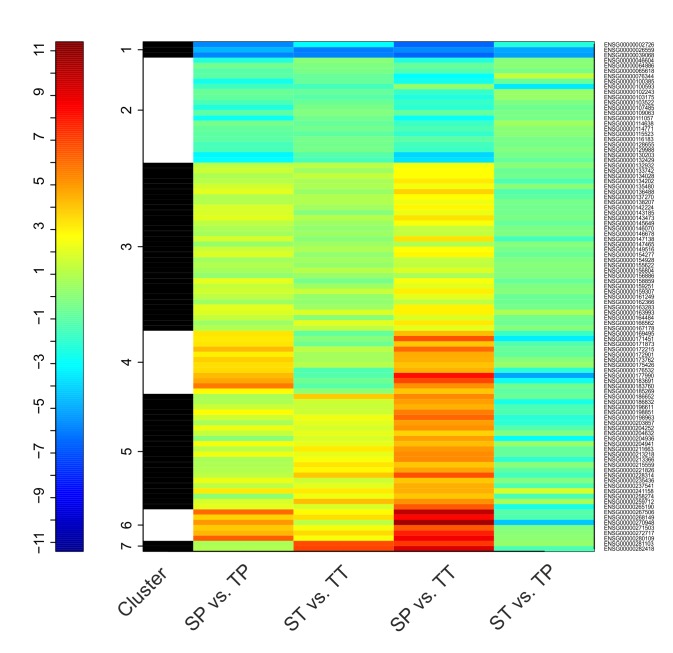
Heat map of log fold count (LogFC) of DE genes in the 4 contrasts.Detected DE genes were clustered based on the logFC value from all contrasts using the k-means method. SP; Singleton preterm, SP; Singleton term, TP; Twin preterm, TT; Twin term.